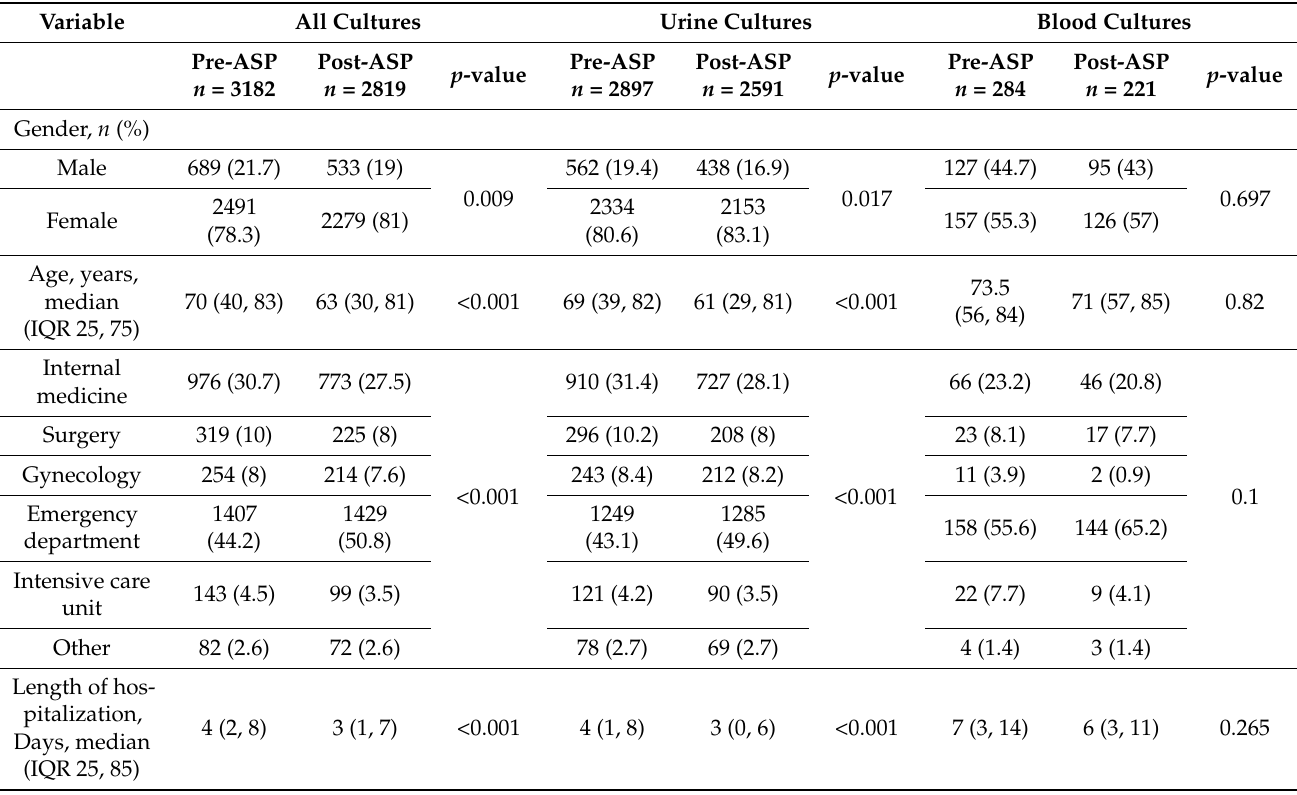
Table 1. Description of the patients included in study. Each patient was included only once per